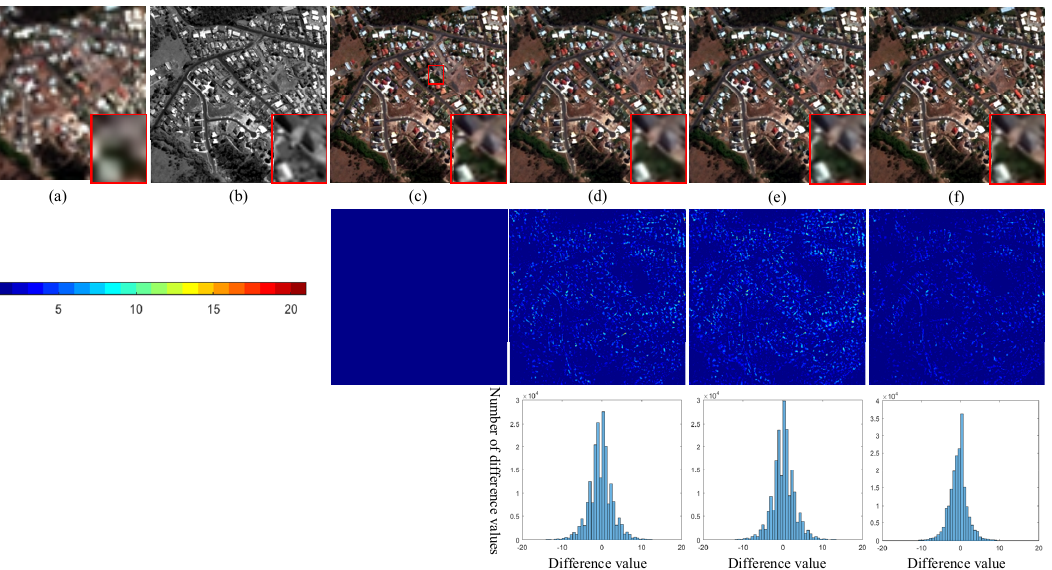
Figure 11. Influences of different attention modules on the GeoEye-1 dataset. ( a ) LR MS image; ( b ) PAN image; ( c ) reference image; ( d ) SCAM; ( e ) SGAM; ( f ) SIAM.